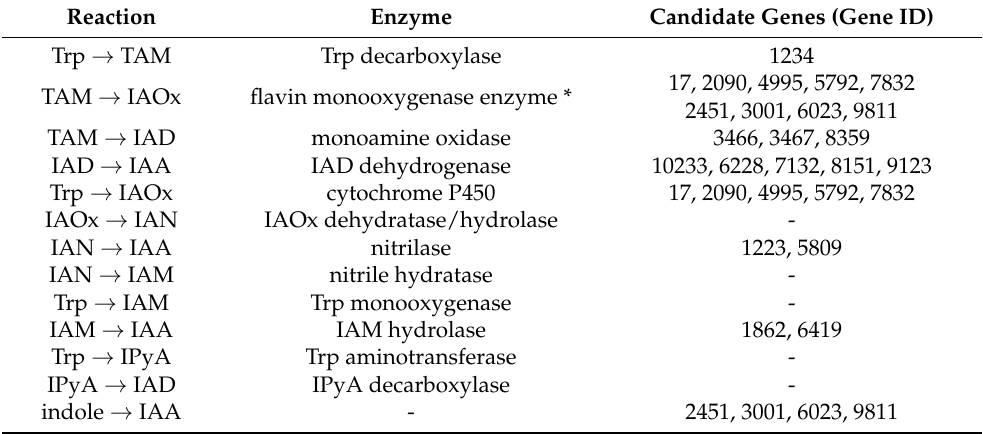
Figure 2. Phenotype of A. thaliana ecotype Columbia (Col-0) with C. asteris . A. thaliana and C. asteris were cultivated on ½ MS/MEAlow under long-day conditions. ( a ) Phenotype of A. thaliana Col-0 after 35 days of cultivation. ( b – e ) β -glucuronidase (GUS) staining of DR5::GUS lines of A. thaliana after 14 days of cultivation. ( f ) Phenotype of A. thaliana Col-0 co-cultivated with C. asteris after 35 days of cultivation. ( g – i ) GUS staining of roots of DR5::GUS lines of A. thaliana co-cultivated with C. asteris after 14 days of cultivation. Table 1. Candidate genes of C. asteris involved in IAA biosynthesis. Shown are the candidate genes in C. asteris to the corresponding enzyme reaction, but certainly this is no evidence that they are expressed in C. asteris . The putative IAA biosynthesis pathways in C. asteris are highlighted in orange in Figure